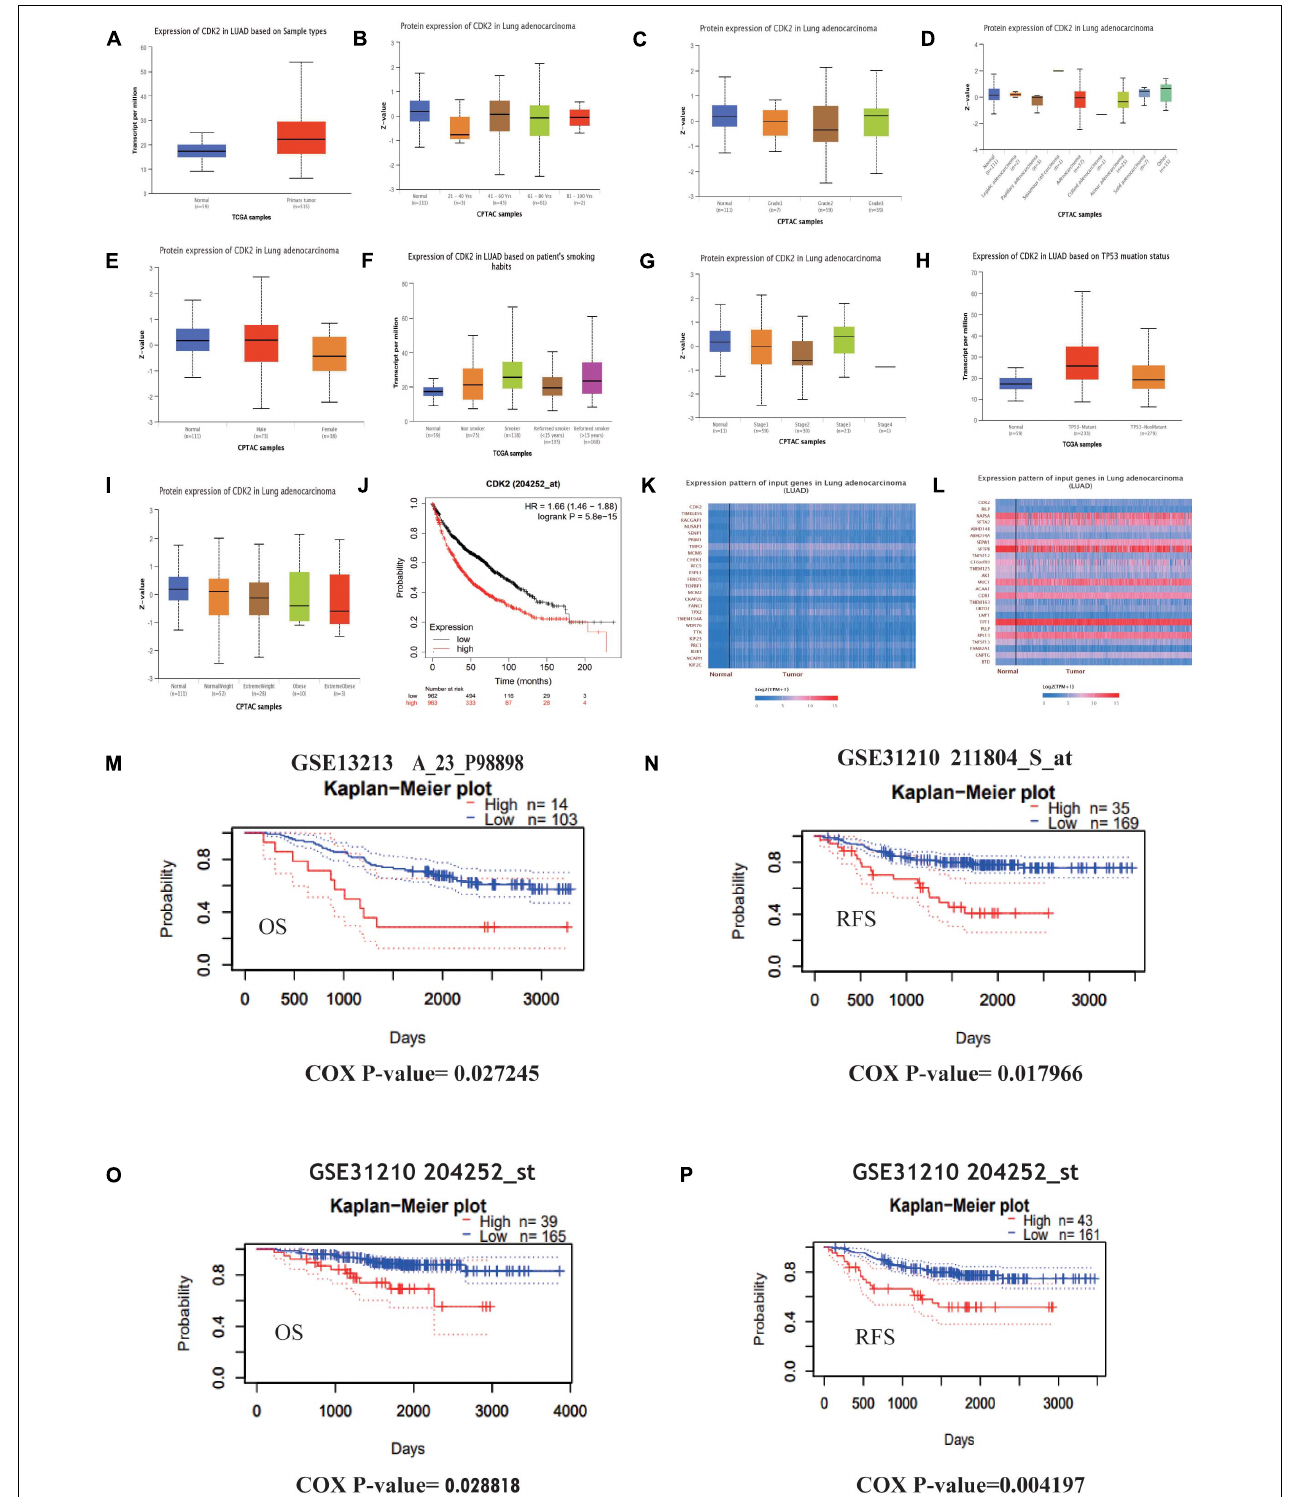
FIGURE 4 | Further study of CDK2 and prognosis analysis in LUAD. (A) The expression of CDK2 was highly in 515 LUAD tissues than 59 normal tissues. (B) Different ages might have differential expression levels of CDK2. (C) The expression of CDK2 was associated with Grade. (D) The types of adenocarcinoma. (E) Gender. (F) Smoking habits. (G) Stage. (H) TP-53 mutation state. (I) Weight. (J) The expression of CDK2 was related to the survival and prognosis of patients with LUAD. (K,L) CDK2-related genes and heat maps. (M–P) The expression of CDK2 influenced the OS and RFS of LUAD patients.